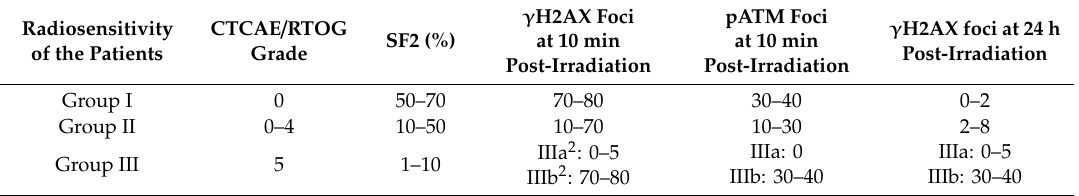
Table1. Numericalvaluesofthemajorendpointsreflectingclinical,cellular,andmolecularradiosensitivity 1 . Radiosensitivity of the